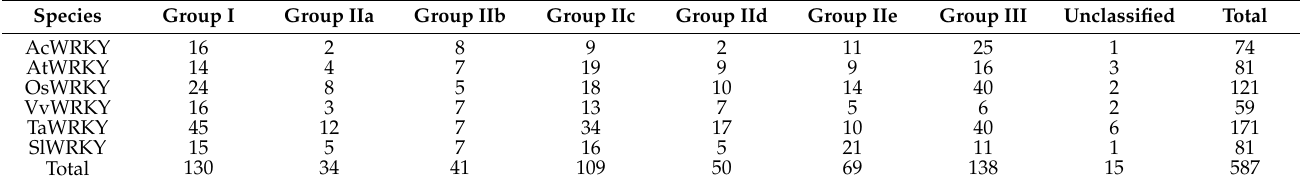
Table 1. List of WRKY genes per species used in the phylogenetic analysis: Allium cepa ( AcWRKY ), Arabidopsis thaliana ( AtWRKY ), Oryza sativa ( OsWRKY ), Vitis vinifera ( VvWRKY ), Triticum aestivum ( TaWRKY ), and Solanum lycopersicum ( SlWRKY ). Data downloaded from Plant TFDB